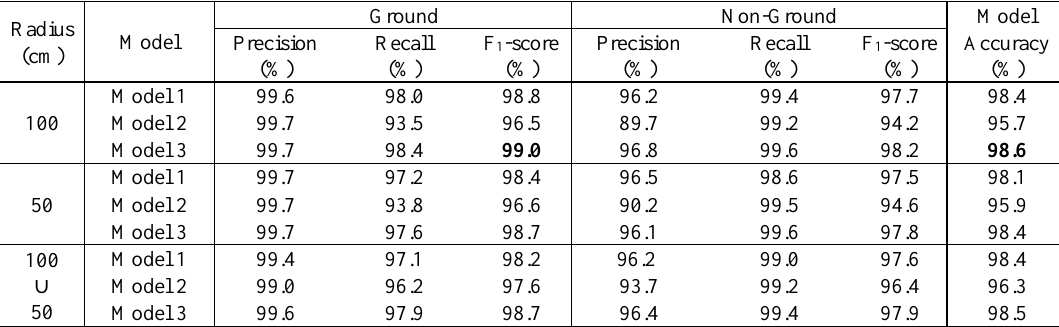
Table 4. Results show the performance of the proposed algorithm for the ACT test